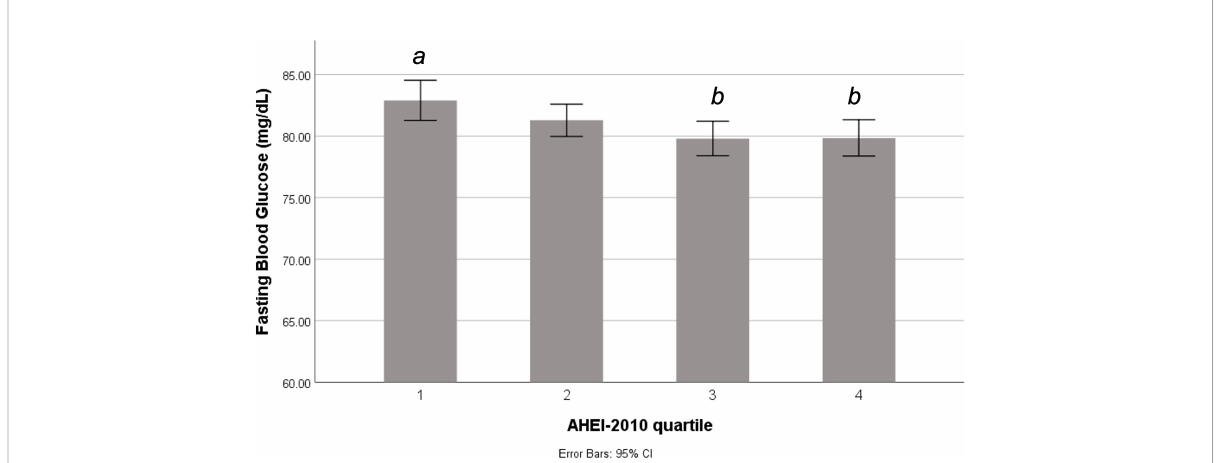
FIGURE 2 Fasting blood glucose according to periconceptional diet quality among pregnant women at risk for GDM. Difference in fasting blood glucose concentrations across quartiles of the AHEI-2010 score among individuals who underwent a 3-hour glucose tolerance test. Different letters indicate signi fi cant difference between quartiles at p<0.05. AHEI, Alternative Healthy Eating